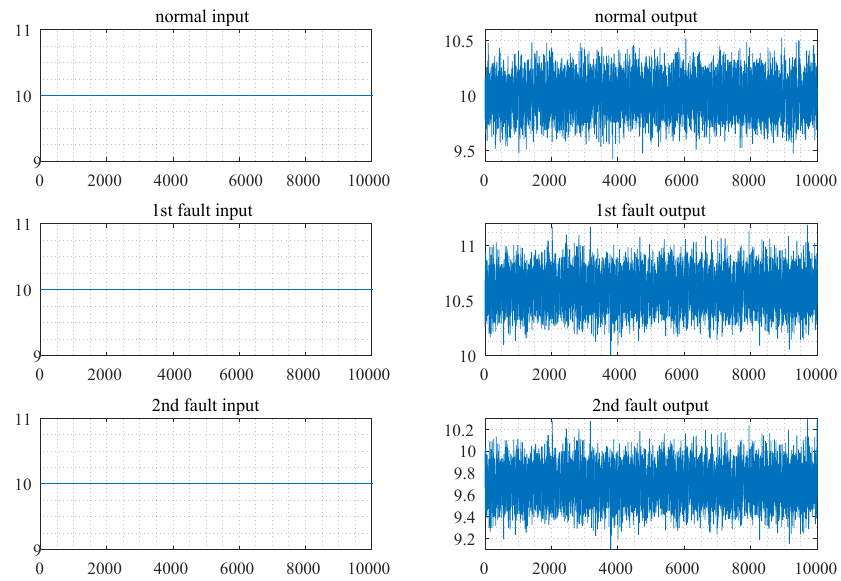
Figure 3. Simulation data set of closed-loop control system.